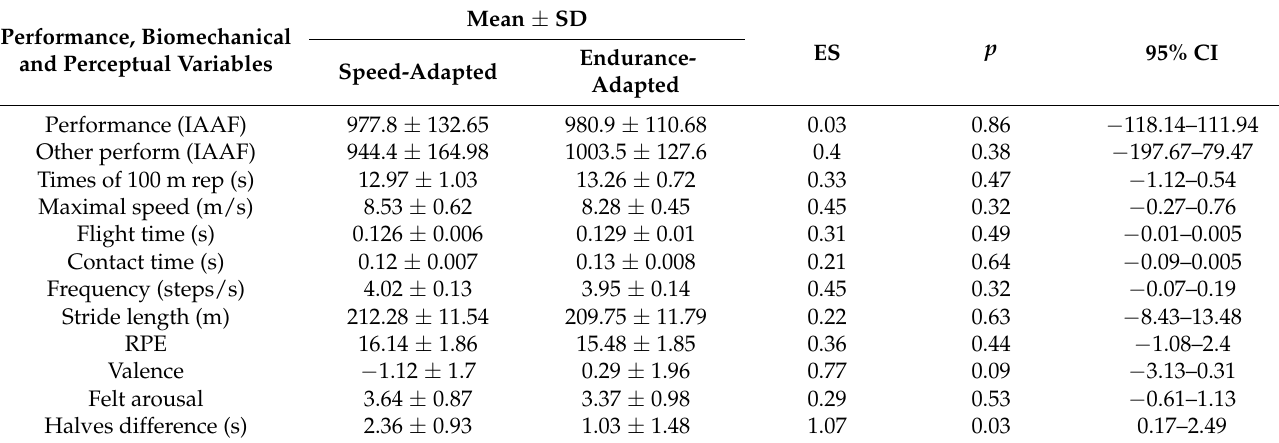
Table 1. Means and standard deviations (SD) of performance, biomechanical and perceptual variables collected to speed- and endurance-adapted milers. Effect sizes (ES), p -value and confidence intervals (95% CI) calculated from the comparison of these variables between groups.